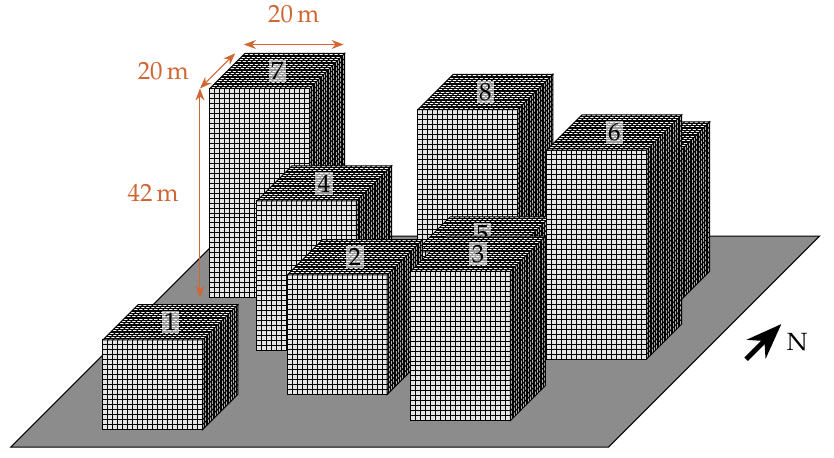
Figure 8. Sketch of the heterogeneous